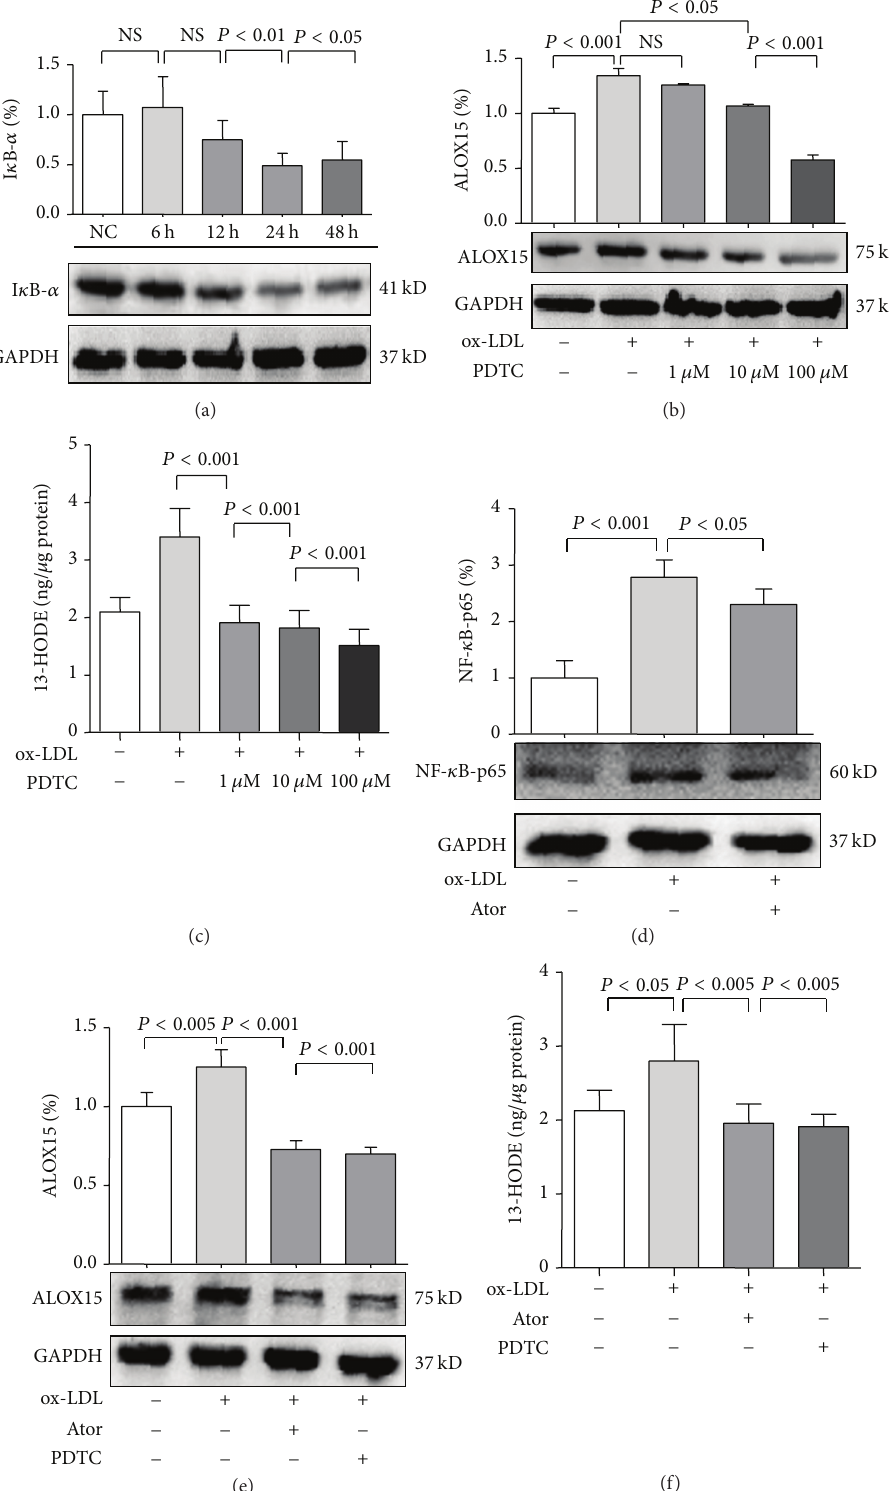
Figure 5: The relationship between atorvastatin and ALOX15. (a) ox-LDL (100mg/L) increased NF- 𝜅 B activity in a time-dependent manner. (b) and (c) NF- 𝜅 B activity affected ox-LDL-induced expression of ALOX15 in HUVECs, which were preincubated with pyrrolidine dithiocarbamate (PDTC) (1 𝜇 M to 100 𝜇 M) for 1h before ox-LDL stimulation. (d) HUVECs were preincubated with atorvastatin (10 𝜇 M) for 8 h before ox-LDL stimulation, after which NF- 𝜅 B-p65 protein levels were examined by western blot analysis. (e) and (f) Effects of atorvastatin and PDTC on ALOX15 protein expression and enzyme activity in HUVECs. Results are expressed as mean ± SD. NC: normal control; NS: not significant. 𝑁 = 3 or 4 per